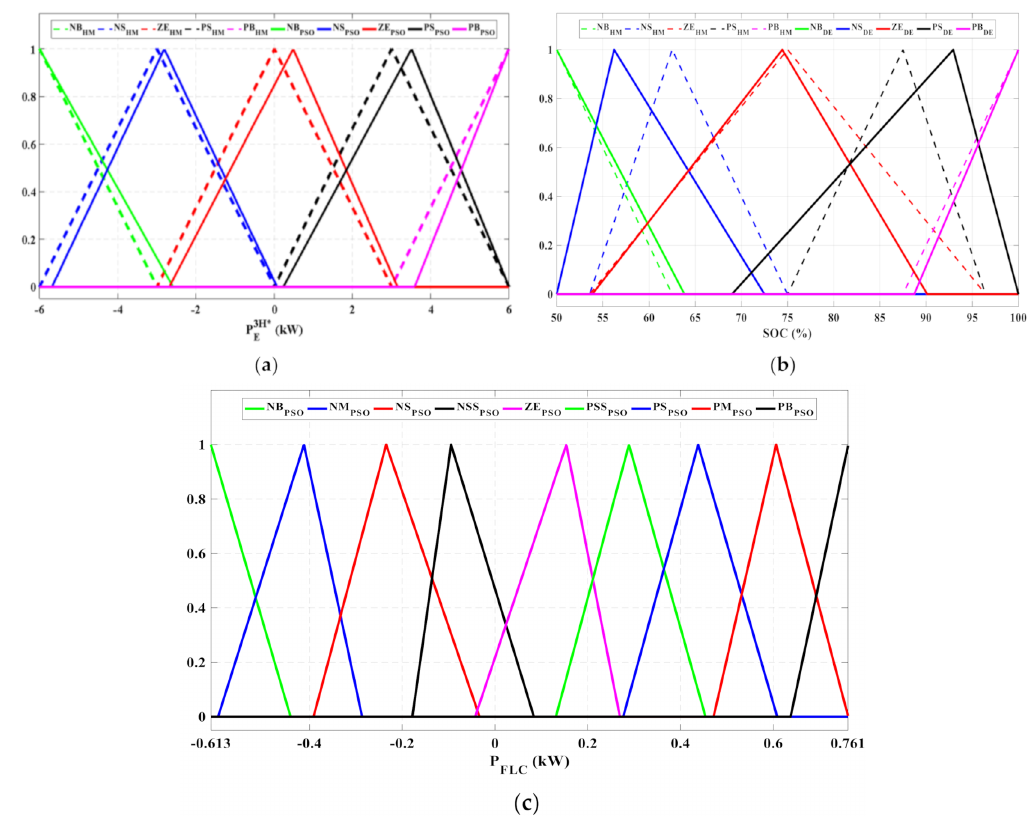
Figure 6. Resulting MFs through Particle Swarm Optimization (PSO) algorithm ( a ) input P 3 H ∗ ( c ) output P FLC .